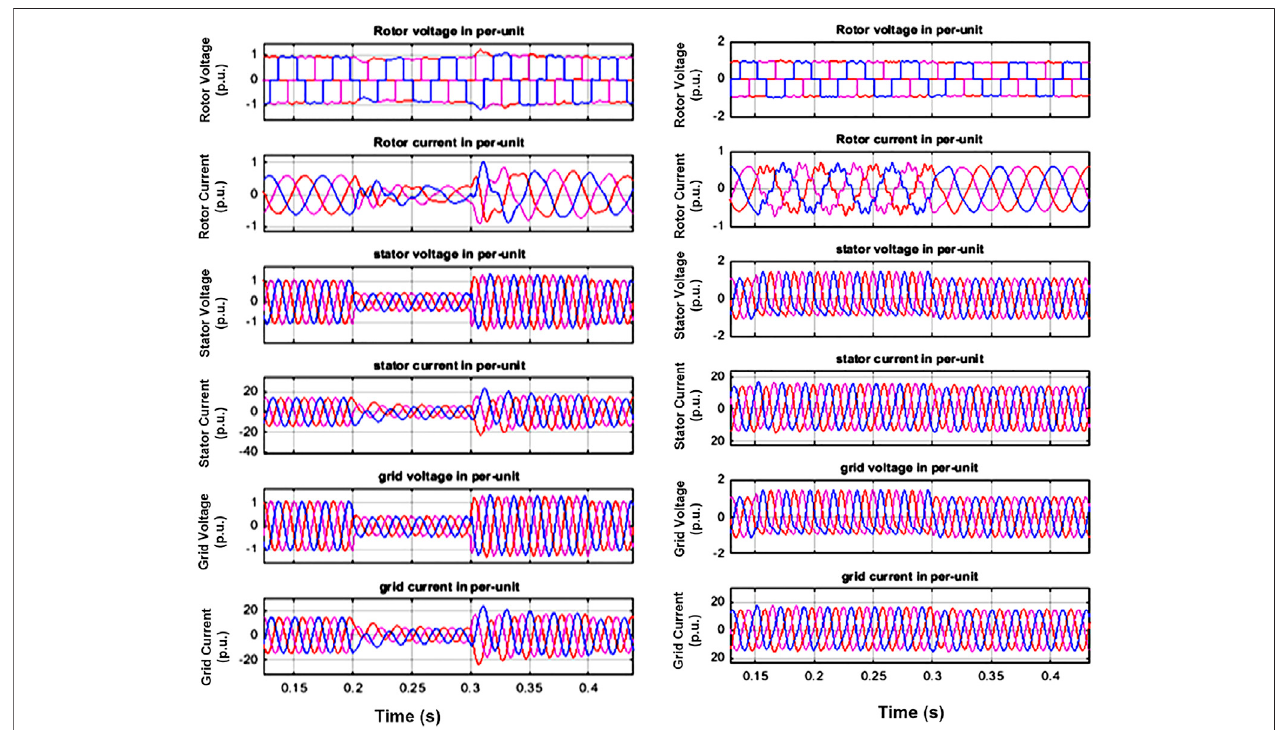
FIGURE 11 | DFIG rotor, stator, and grid voltage and current with (i) control scheme (Moawwad et al., 2016) and (ii) proposed technique.